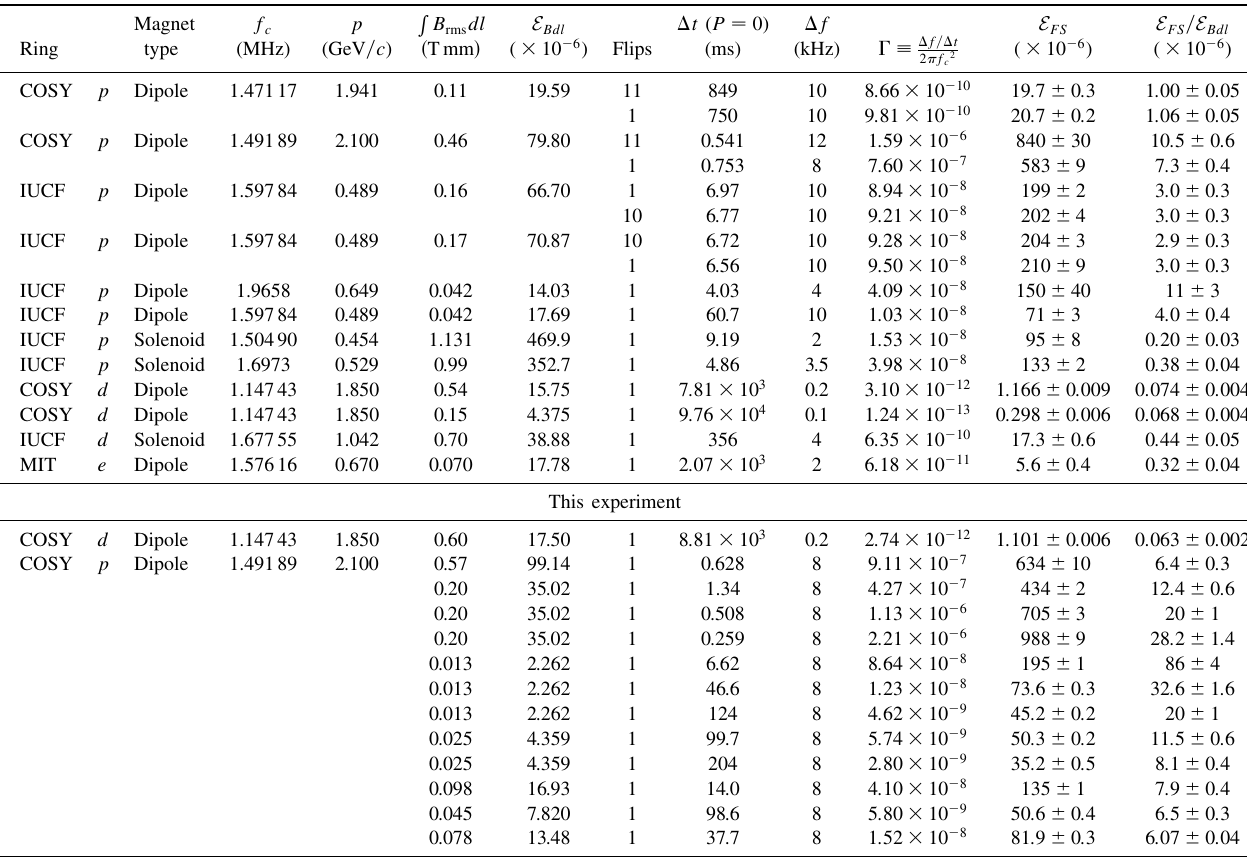
FIG. 9. (Color) Ratio of E to E is plotted vs the frequency ramp range (cid:1) f used for each (cid:1) t curve [31]. E is the resonance FS Bdl FS is obtained using each data point’s R Bdl in Eq. (4) or (5). The strength obtained by fitting the data in each (cid:1) t curve to Eq. (3); E Bdl dashed and solid lines show the ratios predicted by [26–28] and [29,30], respectively. Note that points (a) and (b) overlap, as do points (e)–(h). The data for all points are listed in Table I. TABLE I. Data for Figs. 3 and 7–9 along with relevant experimental parameters for this experiment and earlier experiments [31]. The letters (a)–(p) in column 1 stand for the references listed in [31], while the letters p , d , and e in column 3 denote protons, deuterons, and electrons, respectively. We assumed a (cid:6) 10% error in the rf magnets’ R Bdl for the experiments at IUCF and MIT, and a (cid:6) 5% error in the rf dipole’s R Bdl for our experiments at COSY. Note that, for the bottom 12 COSY proton points, (cid:1) was varied as y explained in Figs. 5 and